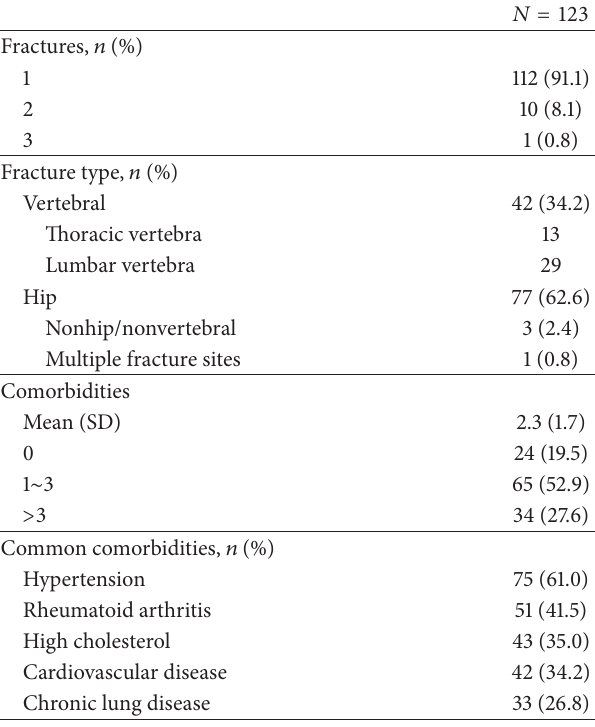
Table 1: Patient demographics. Table 2: Baseline fractures and